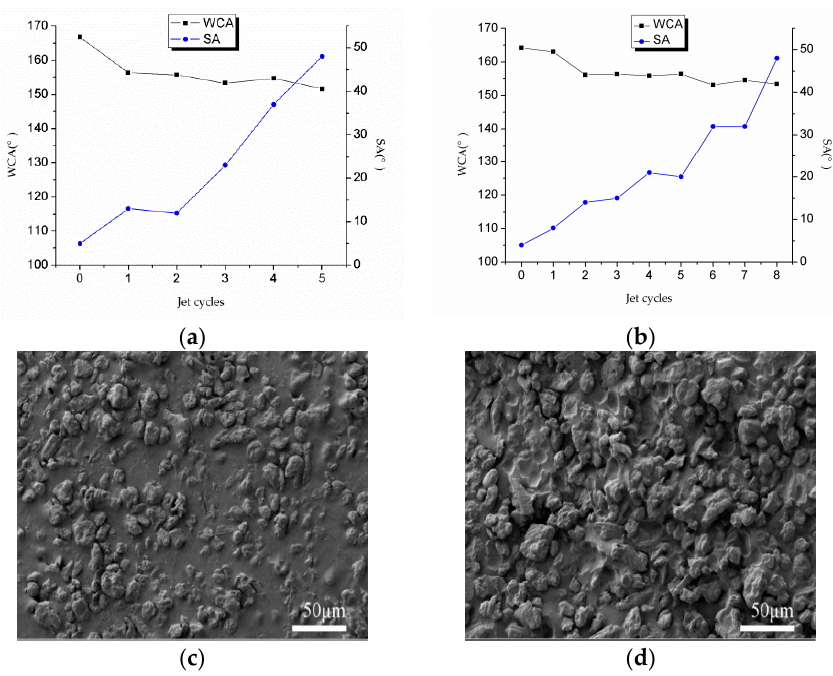
Figure 6. Change curves of the WCA and SA of ( a ) the D coating and ( b ) the E coating in the water jet process; surface morphologies of ( c ) the D coating and ( d ) the E coating after the same five jet cycles.